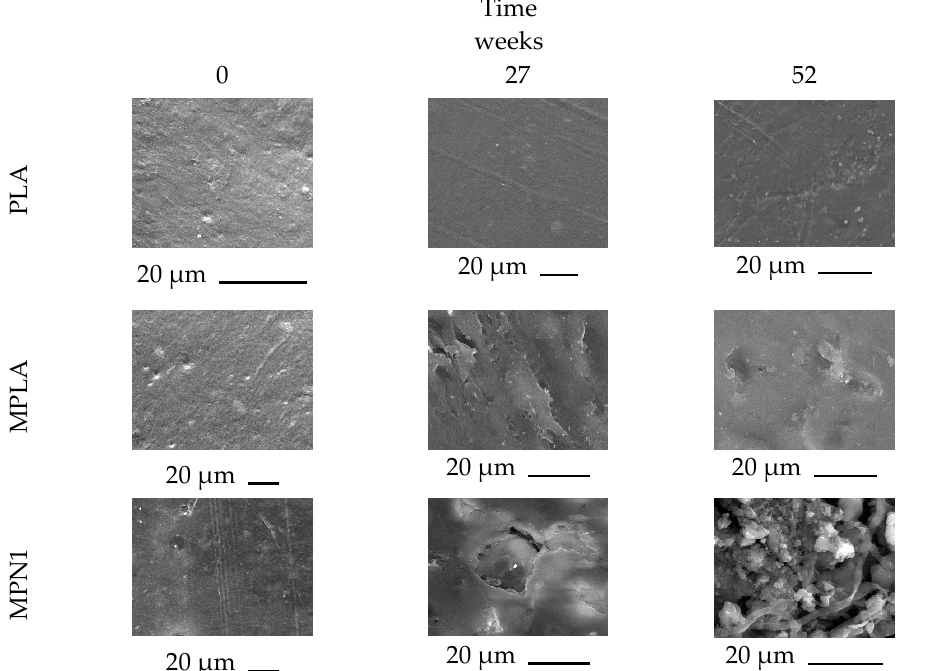
Figure 6. High magnification SEM images of PLA, MPLA, and MPN1 during biodegradation in soil.